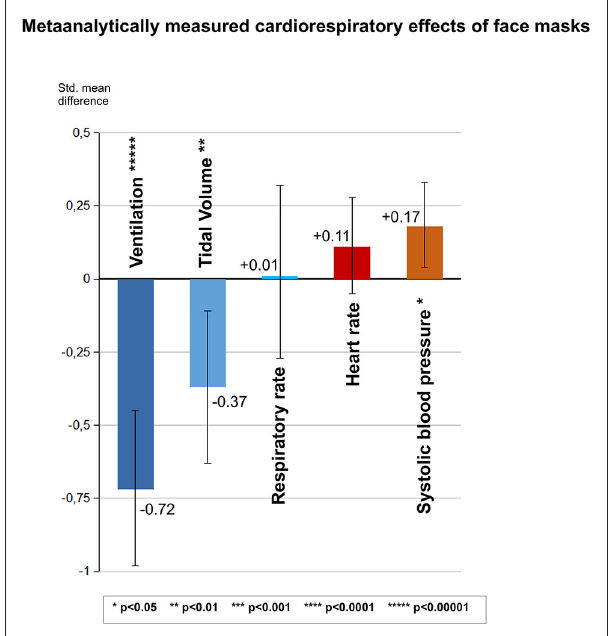
FIGURE10 Summary of pooled meta-analytic evaluation of cardiorespiratory effects during face mask use. The height of the bars reflects the SMD (standard mean difference), their error bars correspond to the confidence intervals. Clear effects for a decrease in ventilation and tidal volume are illustrated, no effect for respiratory rate and weak to low effect for increase in heart rate and systolic blood pressure. For ventilation there is a medium effect size of > 0.5 with a small effect size of > 0.2 for tidal volume of the standard mean difference values according to Cohen (102). The meta-analytical statistical data were as follows: Ventilation: SMD 0.72, 95% CI 0.99 to 0.46, Z 5.36, − − − = p < 0.00001; Tidal volume: